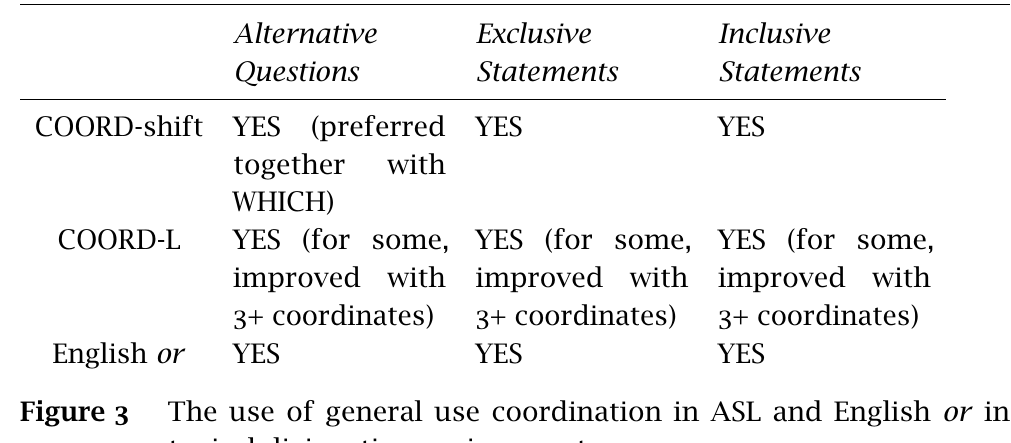
The use of general use coordination in ASL and English or in typical disjunction environments with a sentence-final which